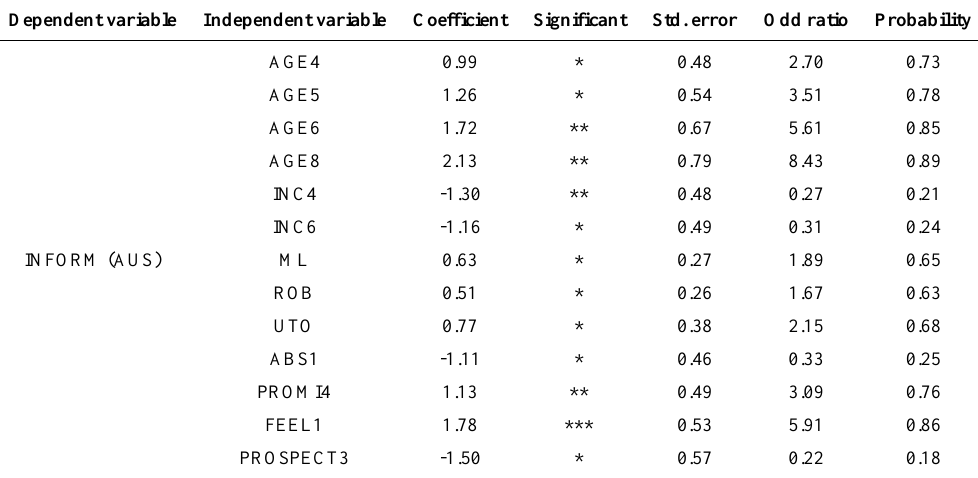
Table A-10. Information and